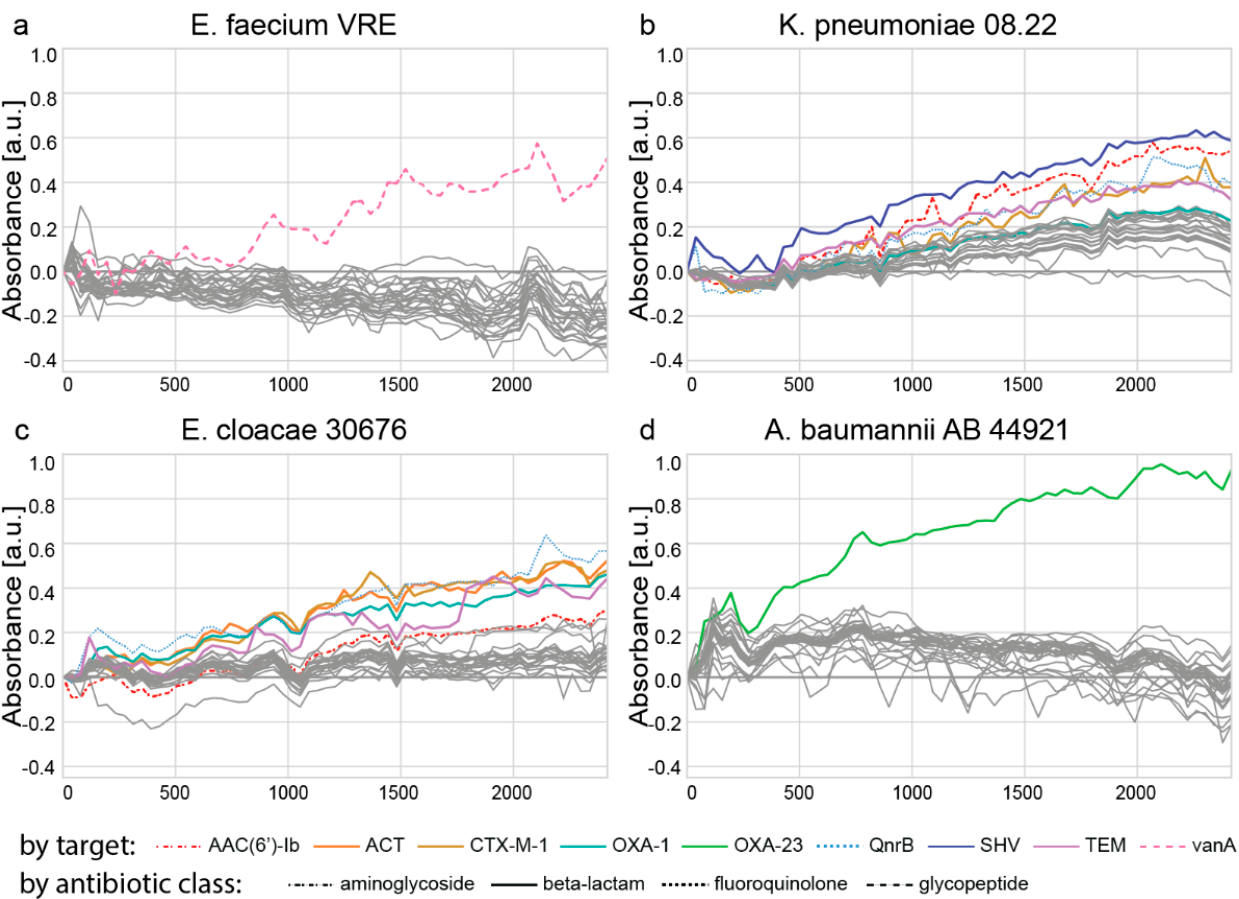
Figure 5. Evaluation of 27 padlock probes targeting antibiotic resistance genes. The genomic DNA of four clinical isolates of the species ( a ) E. faecium , ( b ) K. pneumoniae , ( c ) E. cloacae , and ( d ) A. baumannii was used. Each clinical isolate was incubated with all 27 padlock probes (in single reactions); in parallel, a negative control (H 2 O) was incubated with all 27 padlock probes. The padlock probes were ligated, amplified, and finally, the conversion of the ABTS chromophore by the G-quadruplex DNAzymes was measured. Intended targets per clinical isolate are colored and indicated below the figure; the class of the target antibiotic compound is indicated by the line type.